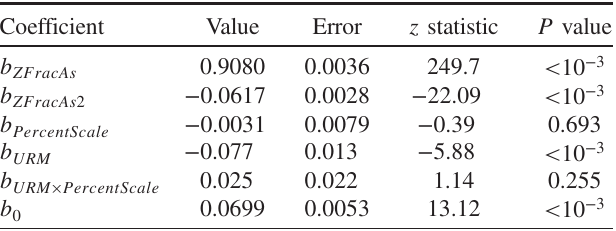
TABLE VI. The coefficients from from an HLM fit to Eq. (6) are shown along with their standard errors, z statistics, and P values. The basic URM grade penalty is present even though we have normalized both the class distributions of grade and of fraction of exam-item A grades given. As expected the grade scale effects are both statistically insignificant after these